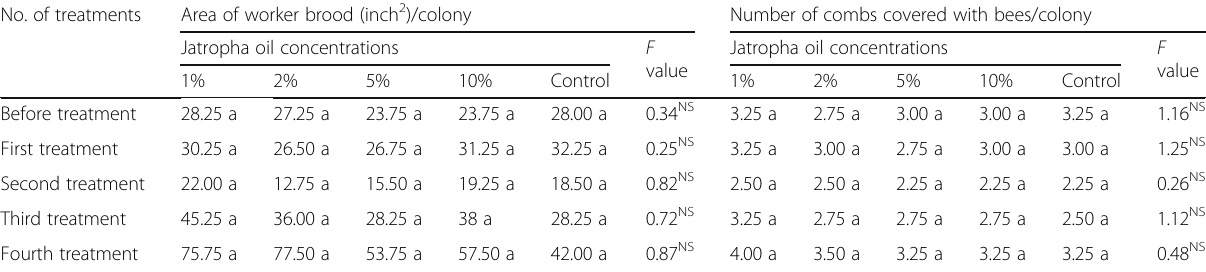
Table 4 Mean area of sealed worker brood (inch 2 ) and number of combs covered with bees in honeybee colonies treated by different concentrations of the jatropha oil No. of